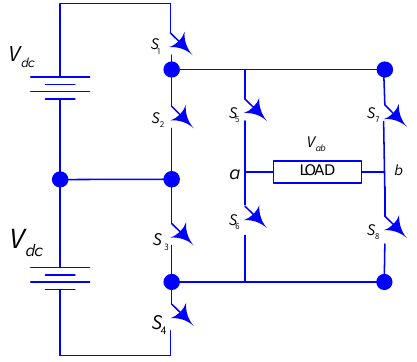
Figure 9. New 5-level symmetrical hybrid multilevel inverter.